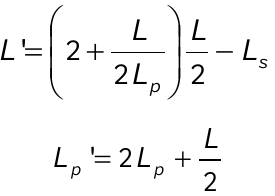
Figure 8. ( a ) Typical topology of a SRR loaded CPW. ( b ) Equivalent circuit model of the unit cell. The magnetic wall concept has been applied, so that the model is that of the one half of the structure.